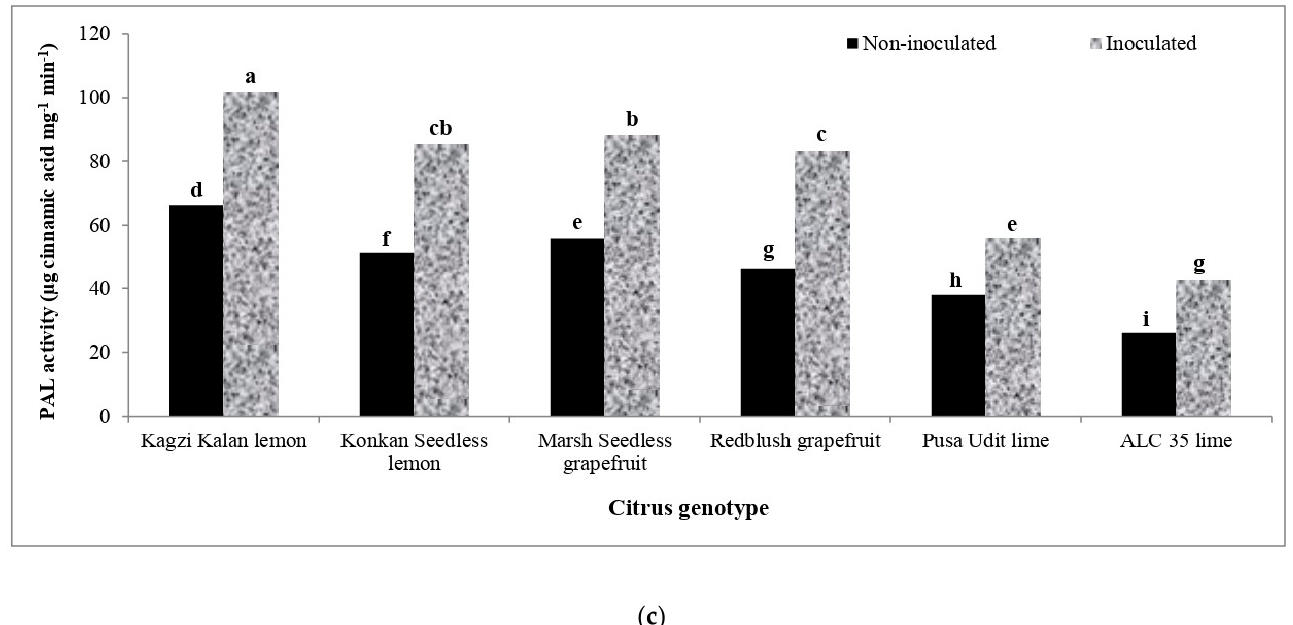
Figure 4. Effect of X. citri pv . citri (Xcc) on the activity of phenyl ammonia lyase (PAL) enzyme in Citrus spp. ( a ) Activity of PAL in Xcc- inoculated and mock-inoculated plants. ( b ) Mean activity of PAL in different citrus genotypes. ( c ) The interaction effect of Xcc on PAL activity in inoculated and non-inoculated plants. Means for inoculation, genotypes and their interaction followed by different lowercase letters are significantly different at p ≤ 0.05 by Tukey’s HSD test.